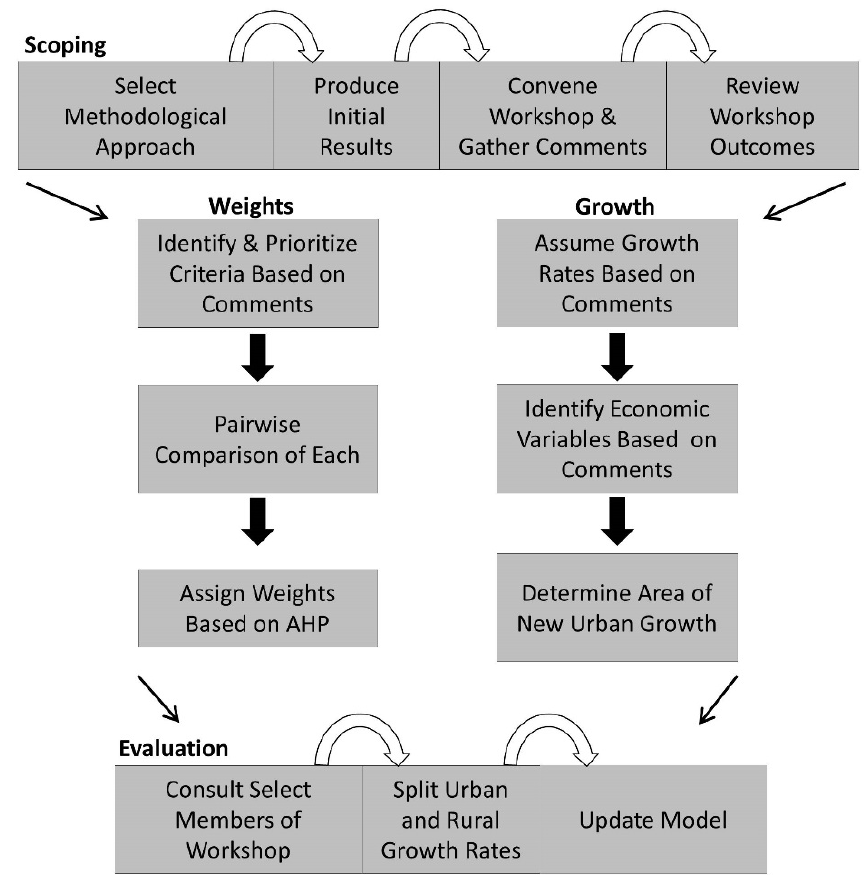
Figure 3. Conceptual diagram of the stakeholder consultation process informing the development of the modeling approach used to produce future land cover scenarios. AHP, pairwise analytical hierarchy